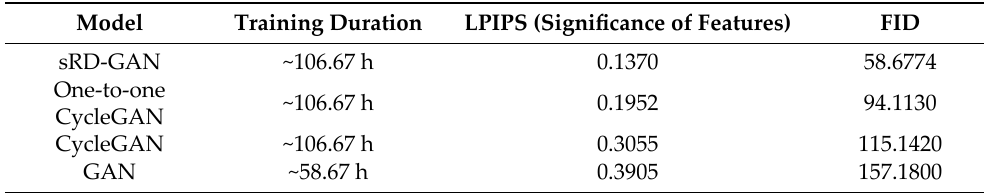
Table 3. Performance metrics of the images generated from different GAN baselines.